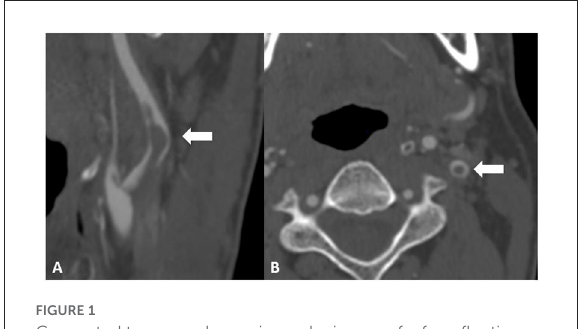
FIGURE1 Computed tomography angiography image of a free-floating thrombus in the proximal left internal carotid artery. (A) depicts a sagittal view of the carotid bifurcation with a contrast filling defect corresponding to a free floating thrombus extending into the distal internal carotid artery lumen (arrow). (B) depicts an axial view of the internal carotid artery with a central contrast filling defect corresponding to the free-floating thrombus in the internal carotid artery.